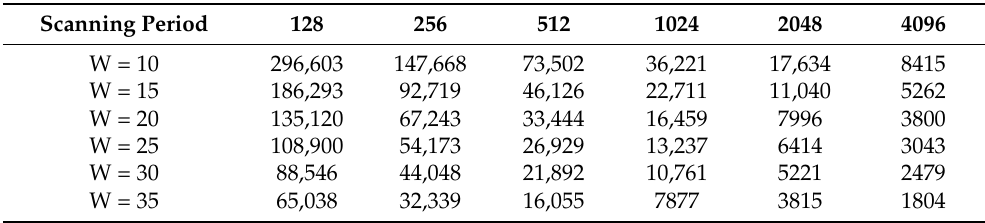
Table 1. Number of windows generated with different scanning period and channel width (The ratio of abnormal to normal data is about 1:10).